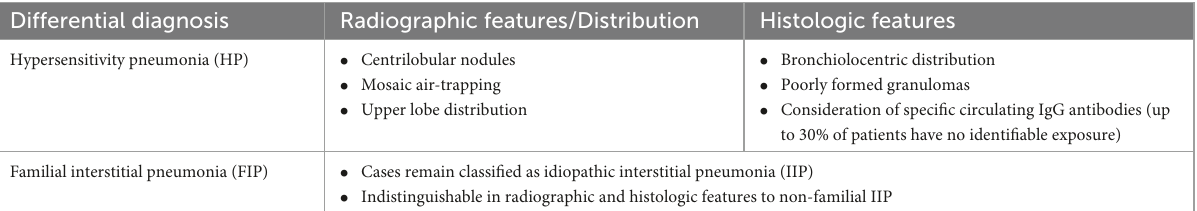
TABLE 5 Radiographic and histologic features of important differential diagnosis according to the classification of the American Thoracic Society (ATS) and European Respiratory Society (ERS) (68, 69). Differential diagnosis Radiographic